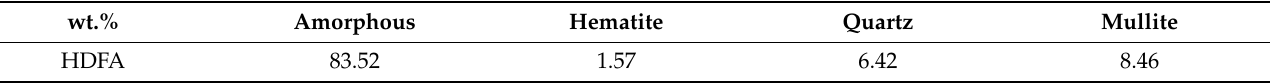
Table 2. Mineralogical analysis of a raw